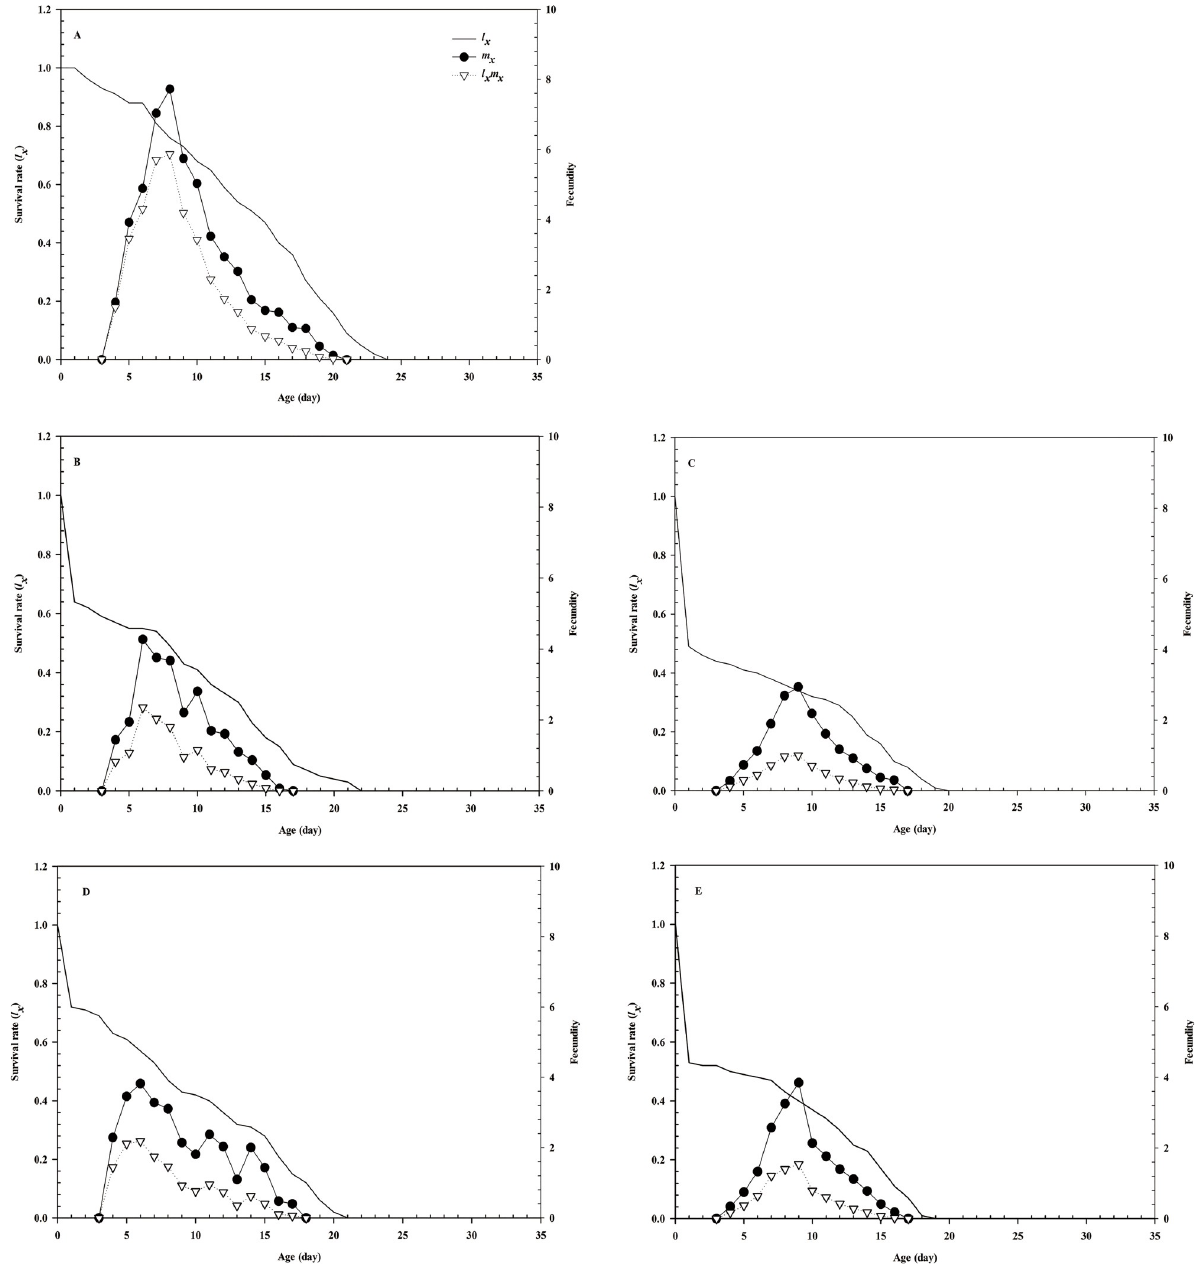
Fig 2. Age-specific survival rate ( l imidacloprid (B), LC 50 imidacloprid (C), LC 30 thiamethoxam (D), and LC 50 thiamethoxam (E)